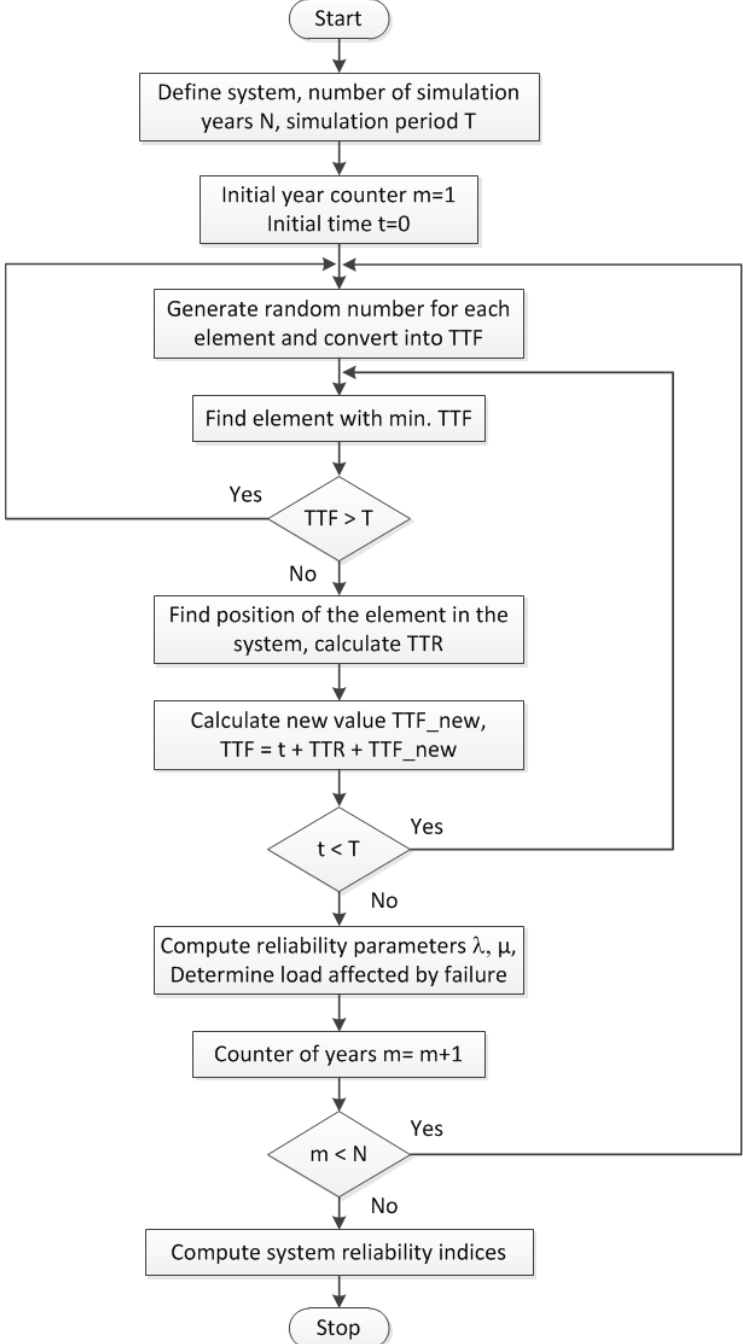
Figure 6. Sequential Monte Carlo algorithm [81,82].